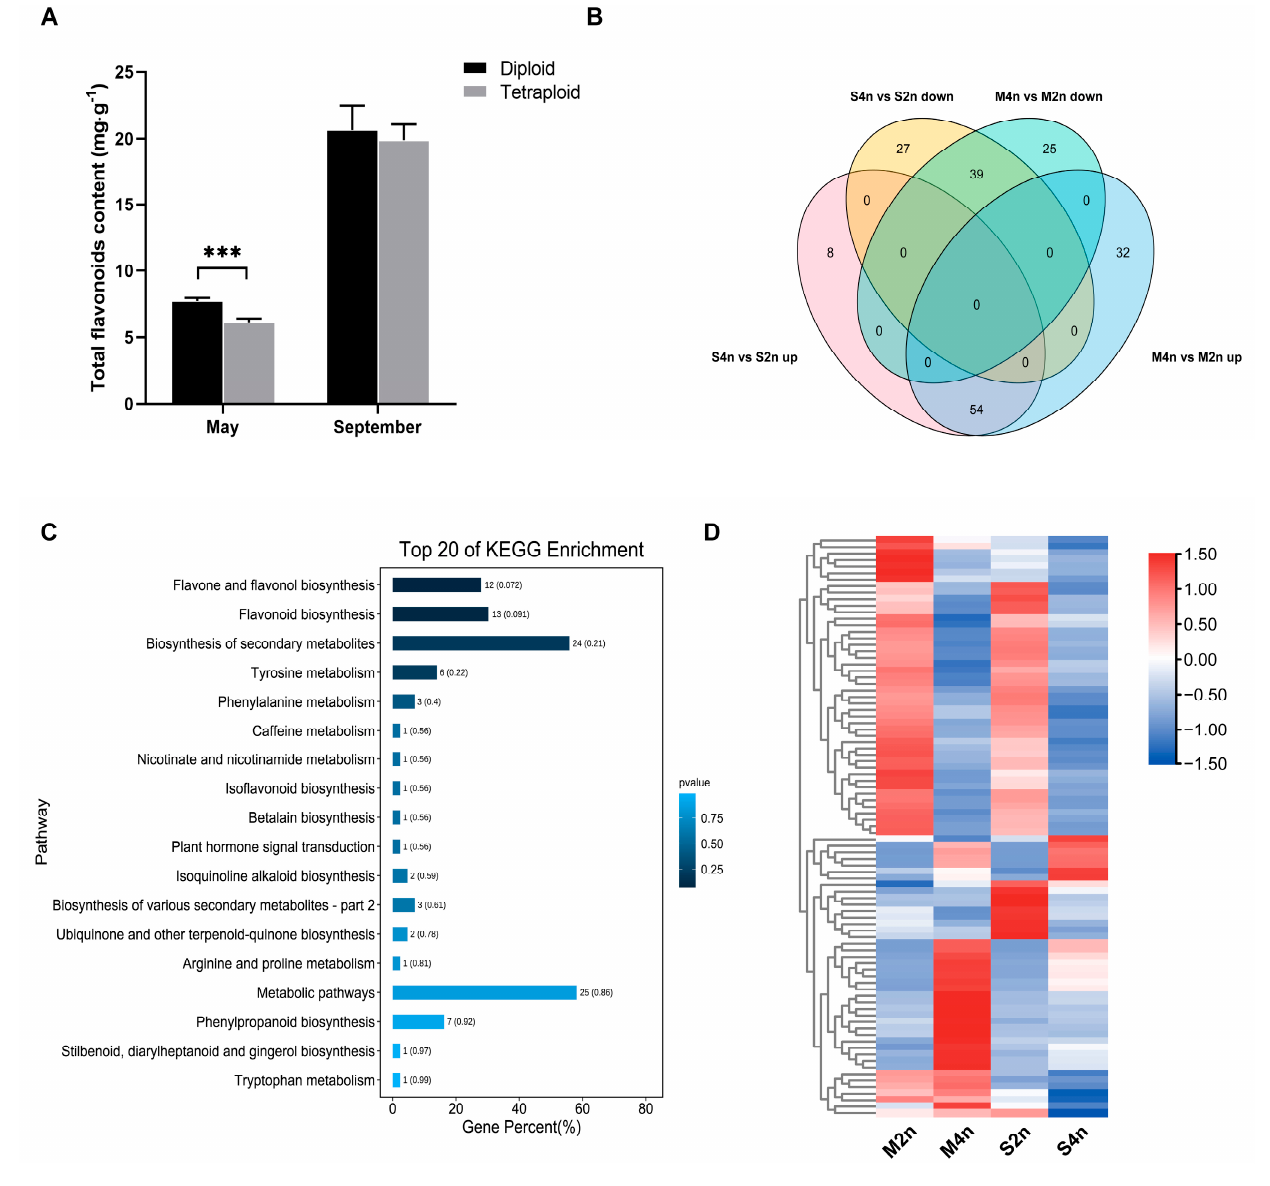
Figure 1. ( A ) Total flavonoid content in the leaves obtained from a diploid and autotetraploid of C. paliurus harvested in May and September, respectively; *** indicates significant difference at p < 0.01; ( B ) Venn diagrams show differential accumulation metabolites (DAMs) in leaves of di- and tetraploid C. paliurus collected in May and September, respectively. Circles and rectangles in the same color represent the same comparison group; ( C ) KEGG pathway enrichment results of DAMs between tetra- and diploid C. paliurus ; and ( D ) heatmap of 89 flavonoids from metabolism data: yellow indicates high-abundant metabolites, whereas low-abundant metabolites are shown in black. The complete list of compounds and concentrations are provided in Table S1 from Supplementary